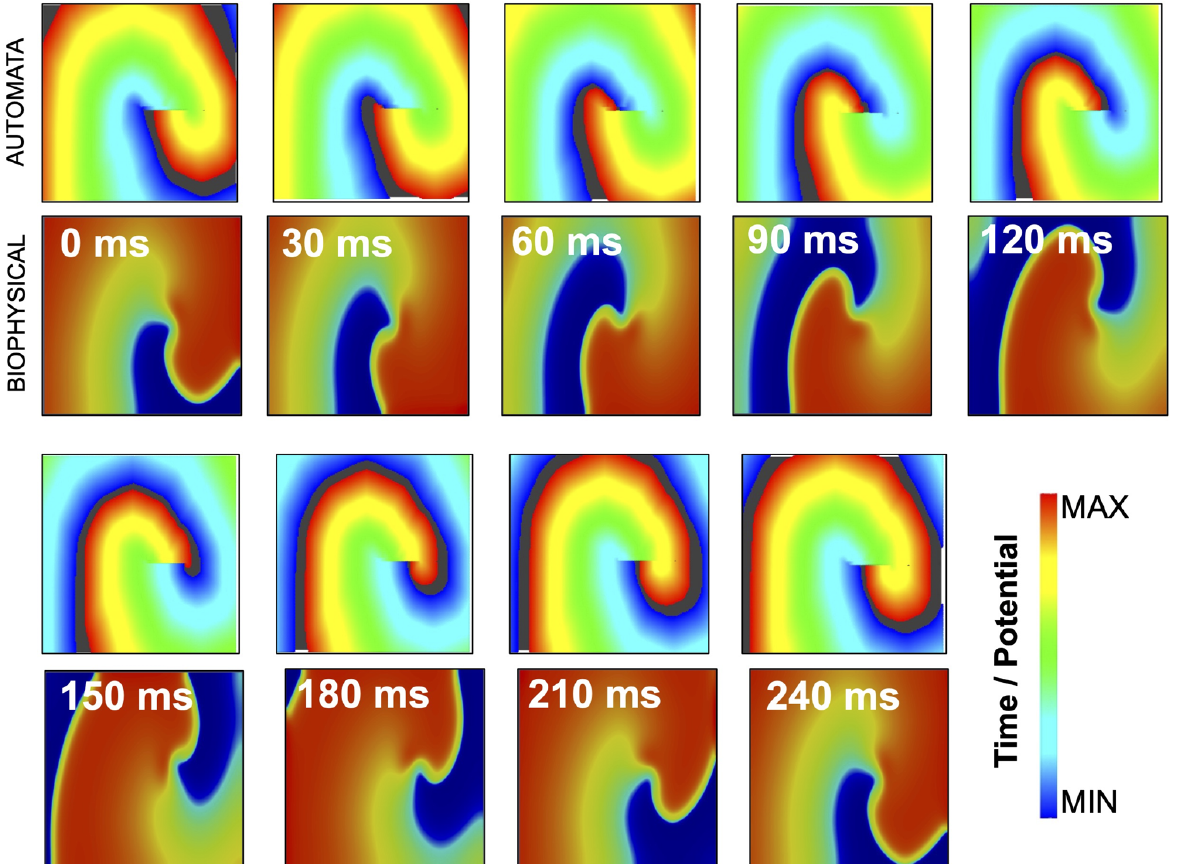
Figure 6. Comparative of simulated rotor spiral waves using a CA and a biophysical model in a slab of tissue. Simulations are shown for 240 ms consecutive time instants after the rotor stabilized. CA simulation is color-coded by time in milliseconds (ms) from the activation (red tones) to the resting state (blue tones). Biophysical simulation shows the equivalent simulation, where colors represent transmembrane potential in millivolts